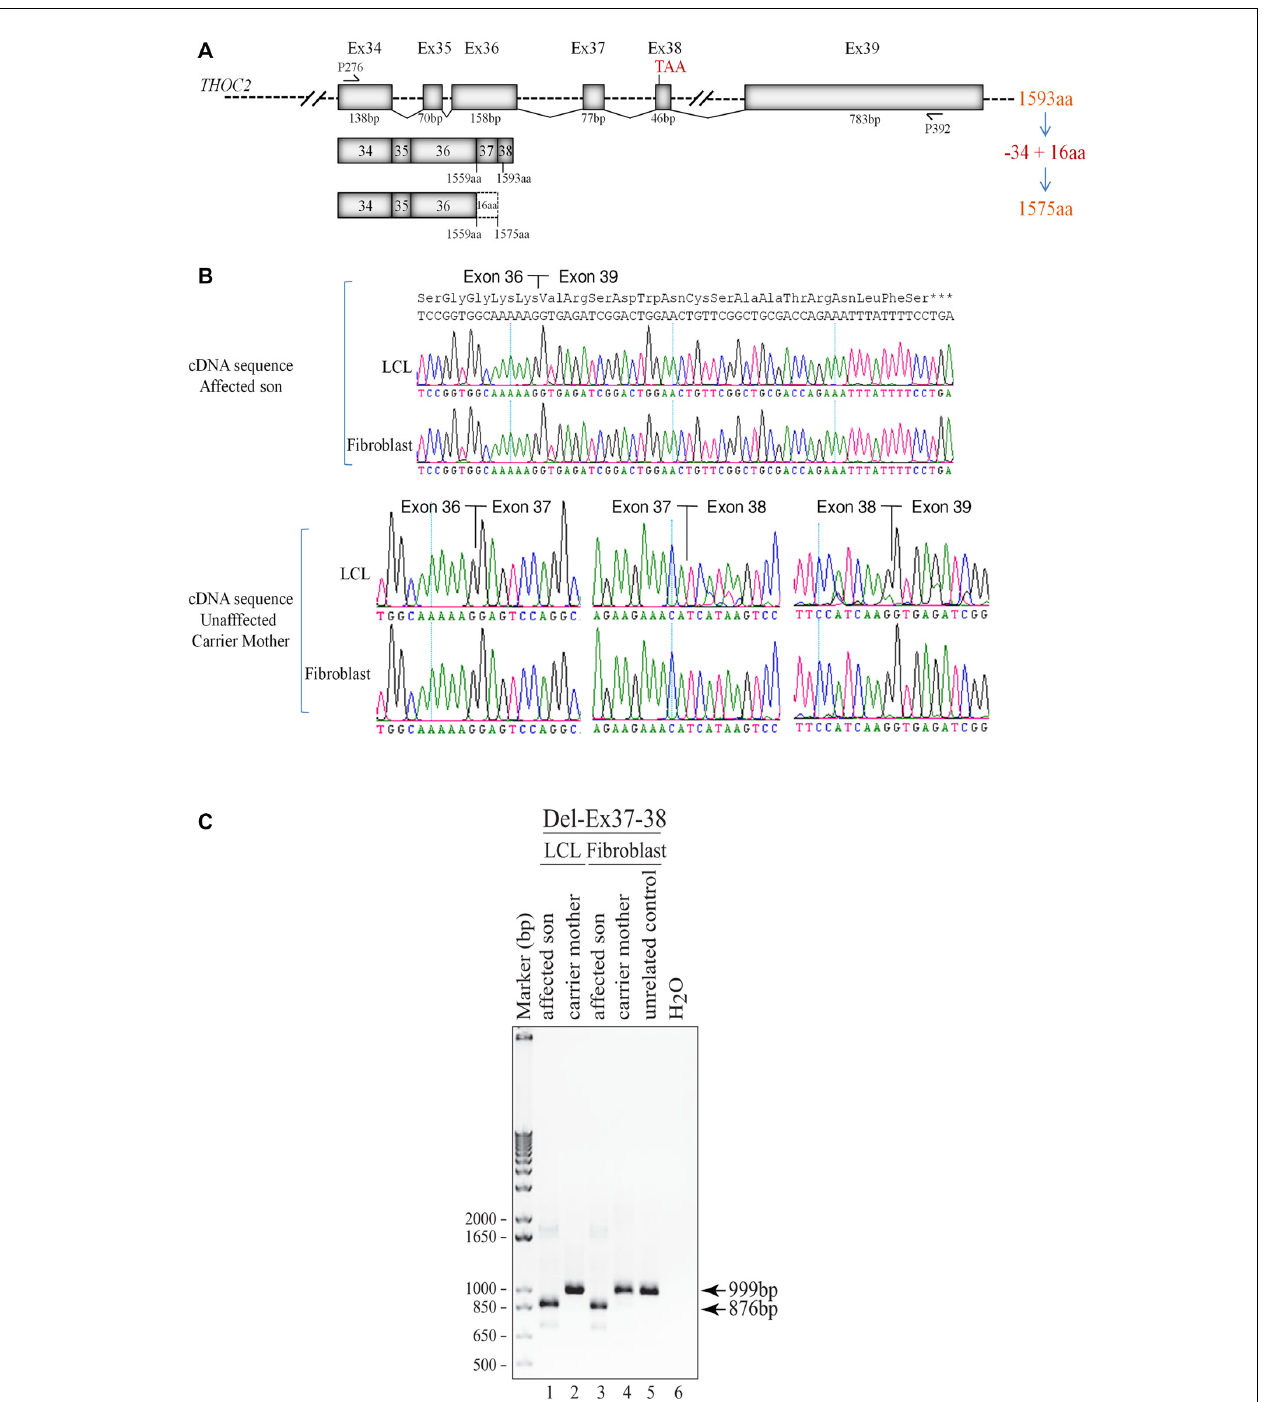
FIGURE 3 | Del-Ex37-38 results in the loss of 34 C-terminal amino acids in the affected individual. (A) Part of the THOC2 gene showing Ex34 to Ex39 and positions of primers. Ex37-38 deleted mRNA translates a 1575 amino acid protein, lacking 34 C-terminal amino acids but adding 16 amino acids encoded from the 3 (cid:48) UTR region of the deleted mRNAs. (B) Sanger sequencing chromatograms of DNA amplified from LCL and fibroblast cDNAs of the affected individual and his heterozygous unaffected carrier mother using primers P276/P392 located within Ex34 and Ex39. Wild type (1593 amino acid) and C-terminal deleted THOC2 protein (1575 amino acids) translated from Del-Ex37-38 mRNA is also shown. (C) Ex37-38 coding sequence is deleted in both fibroblast and LCL THOC2 mRNAs of the affected son but not in the unaffected carrier mother. Total fibroblast and LCL RNAs were reverse transcribed and PCR amplified using primers P276/P392. PCR products (999 bp from the carrier mother and 876 bp from the affected son) were gel purified and Sanger sequenced using P276 and P392 primers.